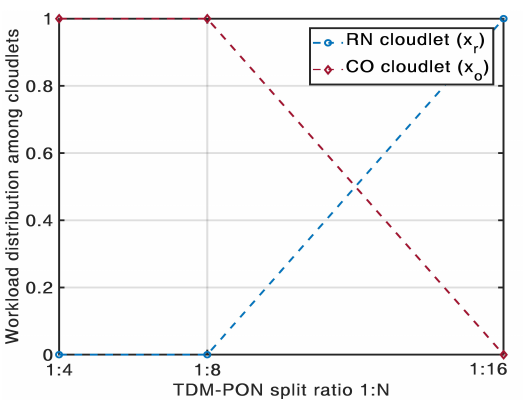
Figure 5. Workload distribution among RN and CO cloudlets against TDM-PON split ratio for a circular area with diameter = 4 km, population density = 4000 people/km 2 , and D QoS = 1